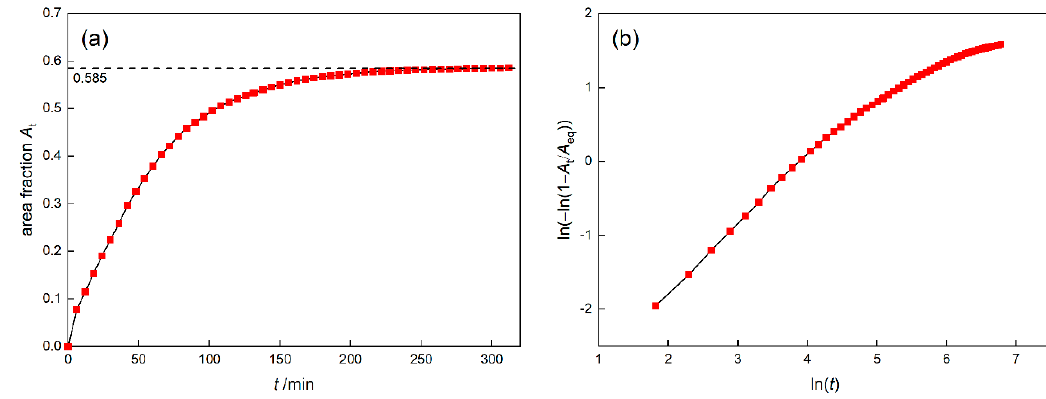
Figure 4. The area fraction of γ (cid:48) phase ( a ) and Avrami plot ( b ) of DD6 superalloy at 1120 ◦ C.